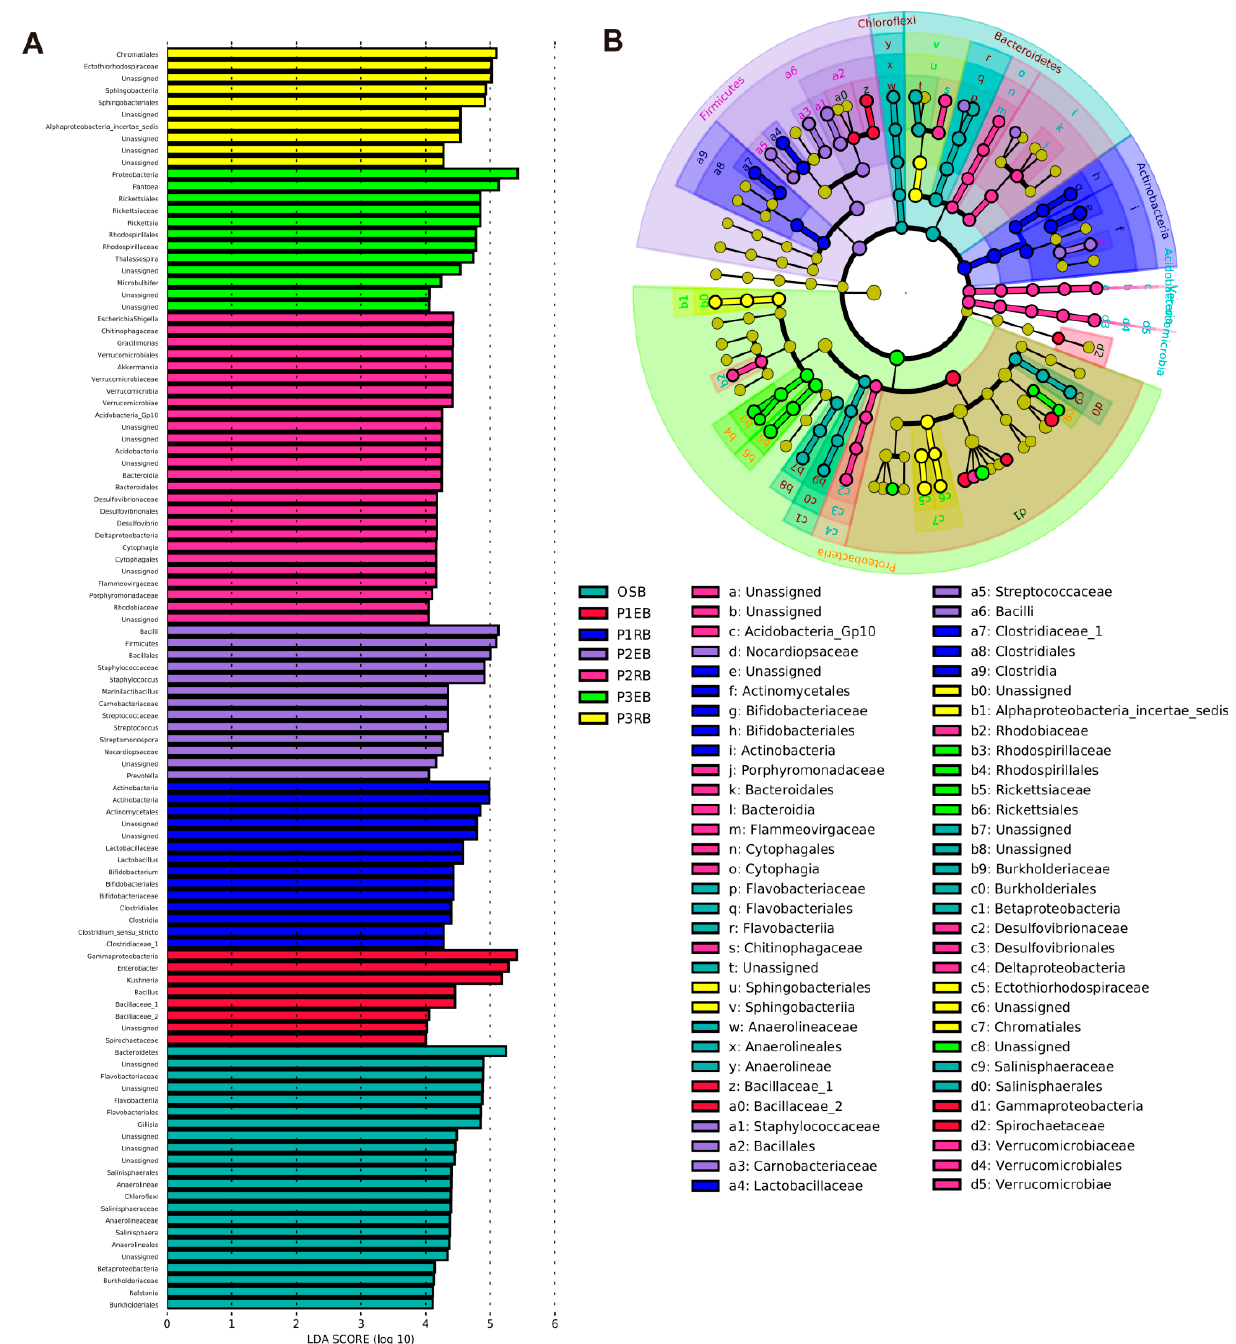
Figure 4. The bacterial taxa with differential abundance among 7 different sample groups, based on LEfSe software analysis. ( A ) Identified biomarkers ranked by the effect size in different samples. The habitat biomarkers were identified as being significantly abundant (LDA > 4, p < 0.05) when com ‐ pared among samples. OSB refers to the open bare soil bacteria group, P1EB refers to the group of endophytic bacteria associated with P1, P1RB refers to the group of rhizospheric bacteria associated with P2, P2EB refers to the group of endophytic bacteria associated with P2, P2RB refers to the group of rhizospheric bacteria associated with P2, P3EB refers to the group of endophytic bacteria associated with P3, and P3RB refers to the group of rhizospheric bacteria associated with P3. ( B ) A cladogram representing the hierarchical taxonomic structure of the identified habitat biomarkers generated us ‐ ing LEfSe is shown. Each ring represents a taxonomic level, with phylum, class, order and family emanating from the center to the periphery. Each circle is a taxonomic unit found in the dataset, with circles or nodes shown in color where the taxon represented a significantly more abundant group.